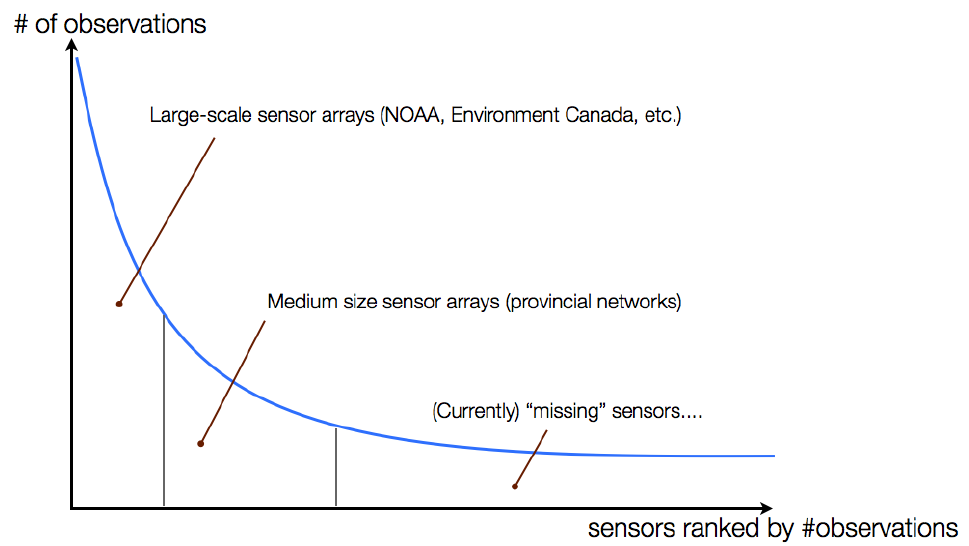
Figure 1. The sensor web long